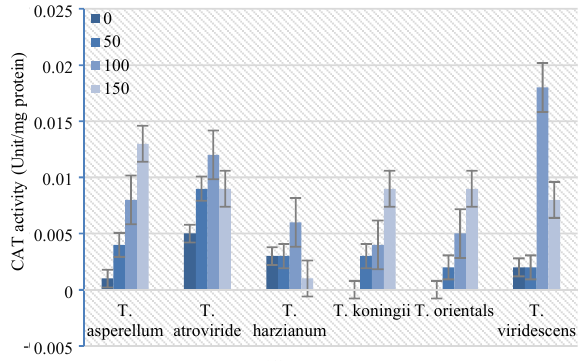
Fig. 2. Catalase activity (unit/mg protein) in fungal strains exposed to various concentrations of α-naphthol (Catalase activity increased at higher α-naphthol concentrations; significant differences between various treatments;